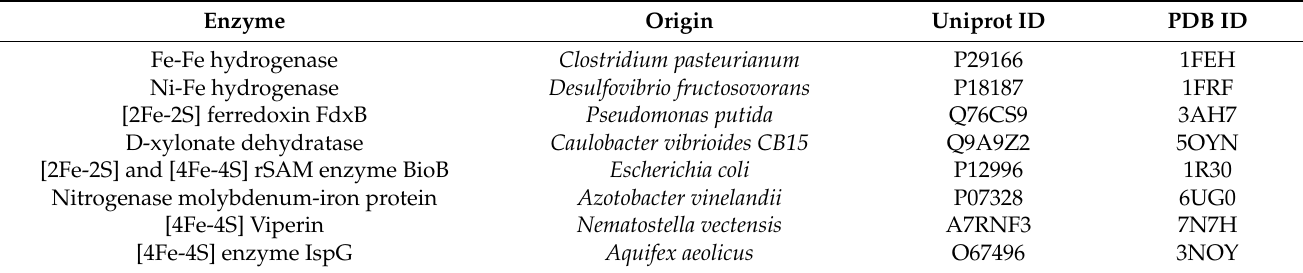
Table A1. Crystal structures of